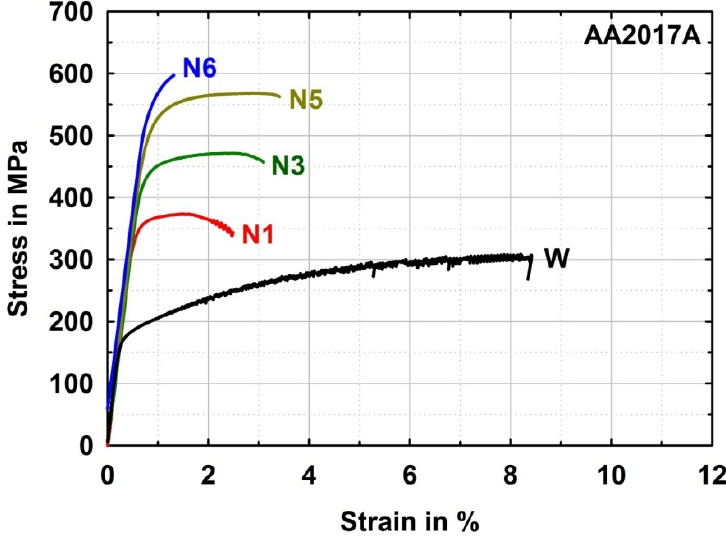
Figure 4. Selected stress-strain data of the commercial alloy AA2017A after ARB processing to different ARB cycles N1 to N6 and reference state W